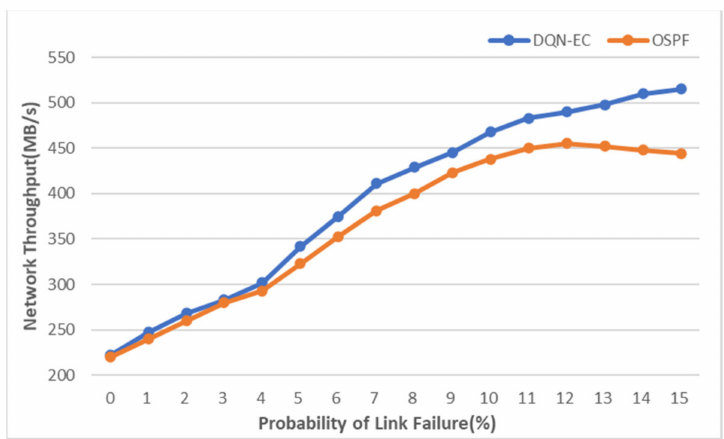
Figure 10. Network throughput based on the probability of a link